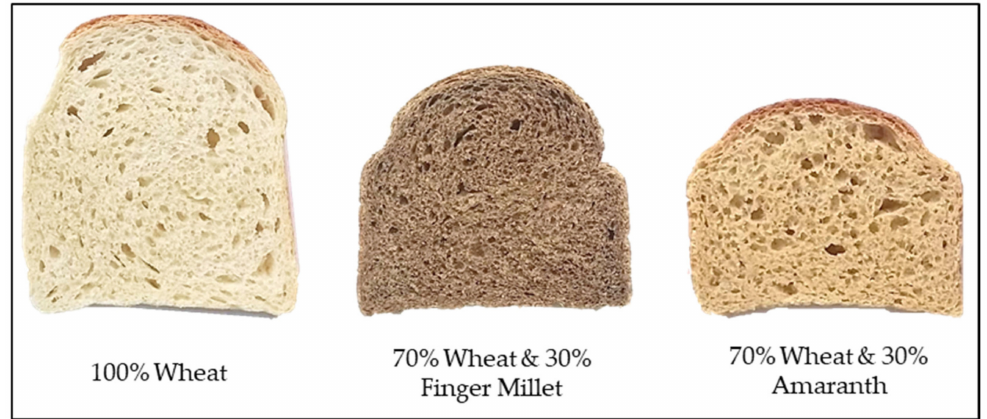
Figure 1. Cut-through sections of breads produced using 100% wheat flour, 70% wheat + 30% native finger millet flour and 70% wheat + 30% amaranth